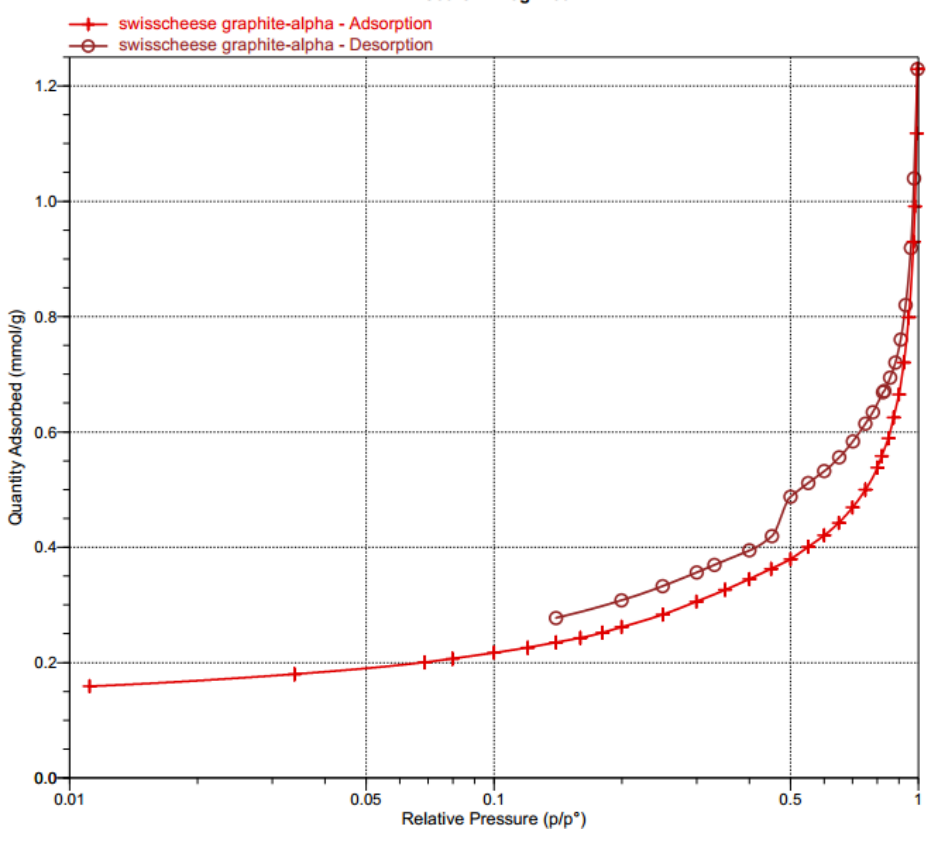
Figure A2. N2 isotherm of SCG.